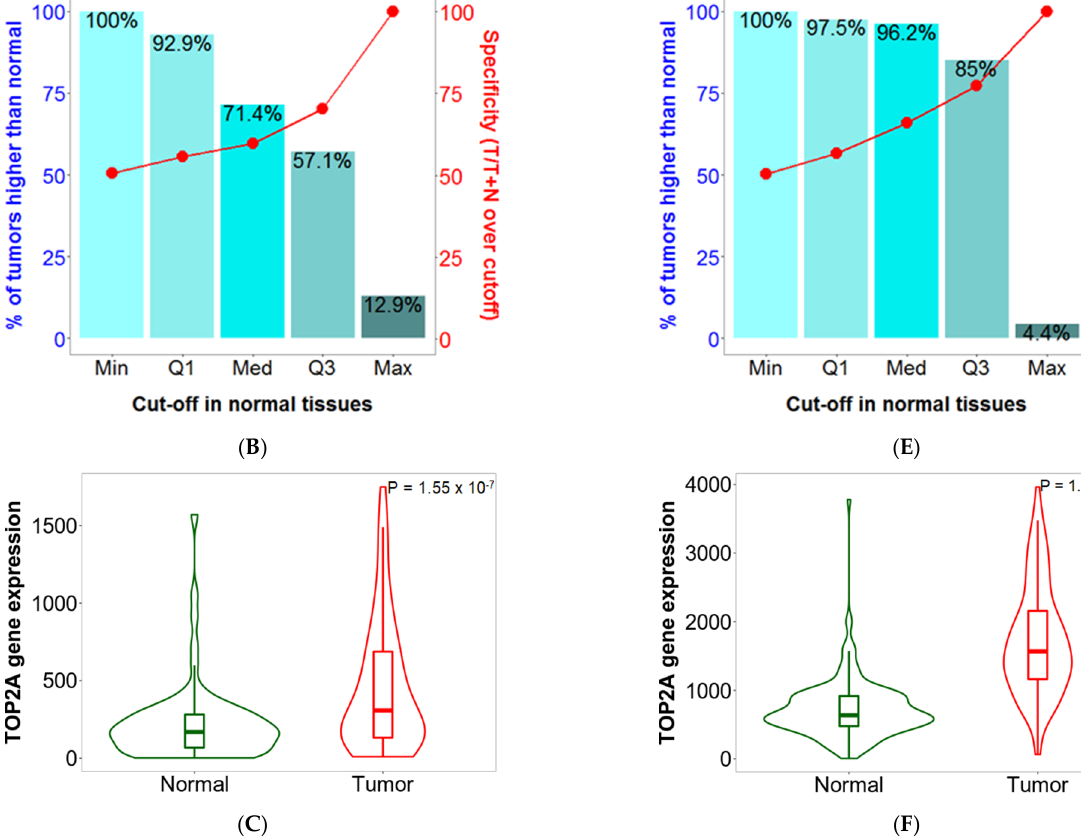
Figure 2. Boxplots ( A , D ), bar charts ( B , E ) and violin plots ( C , F ) of TOP2A gene expression in breast (left) and colon cancer (right) when comparing paired normal and tumor gene array data. The bars represent the proportions of tumor samples that show higher expression of the selected gene compared to normal samples at each of the quantile cutoff values (minimum, 1st quartile, median, 3rd quartile, maximum). Specificity is calculated by dividing the number of tumor samples with the sum of tumor and normal samples below each given cutoff. In cases where the fold change was over 1, those “ over ” were used instead of those “ below ”.